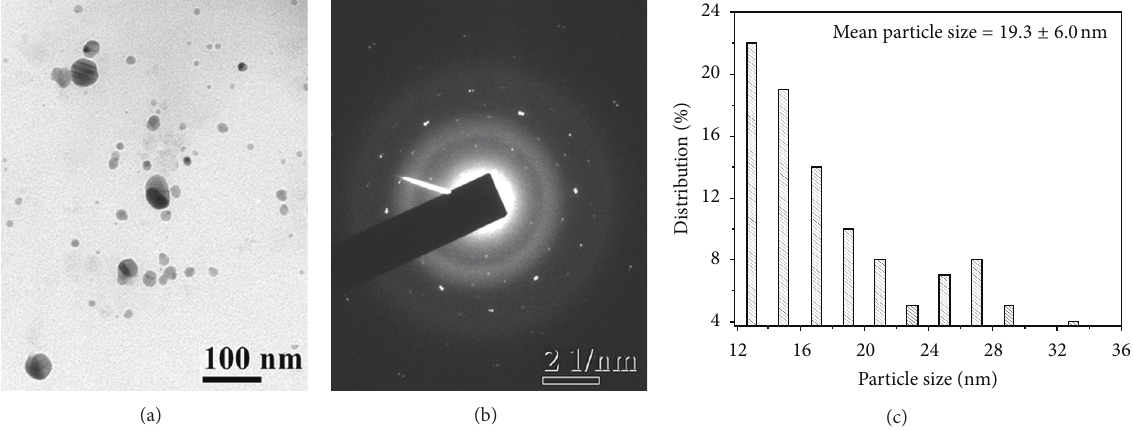
Figure 3: TEM images of SDS capped silver nanoparticle, at (a) 100nm scale, (b) corresponding SAED pattern, and (c) histogram showing the particle size distribution.